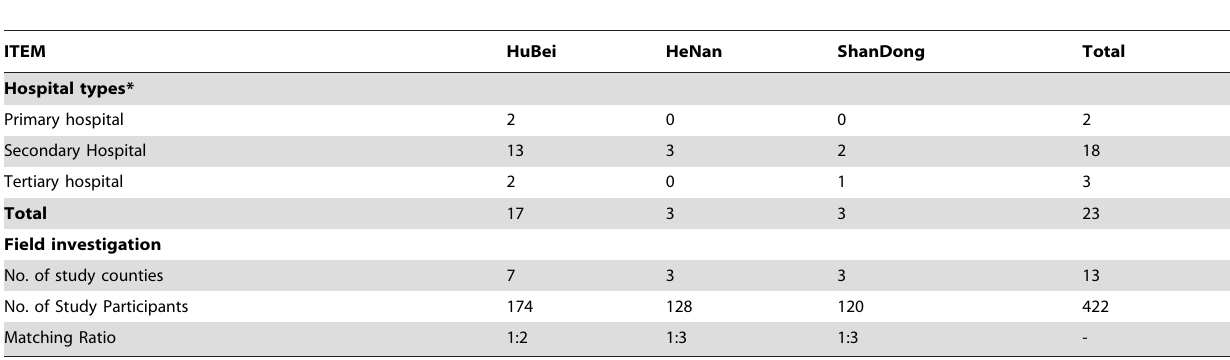
Table 1. Baseline information regarding study sites, sample size and methods, Henan, Hubei and Shandong provinces, China, 2011.